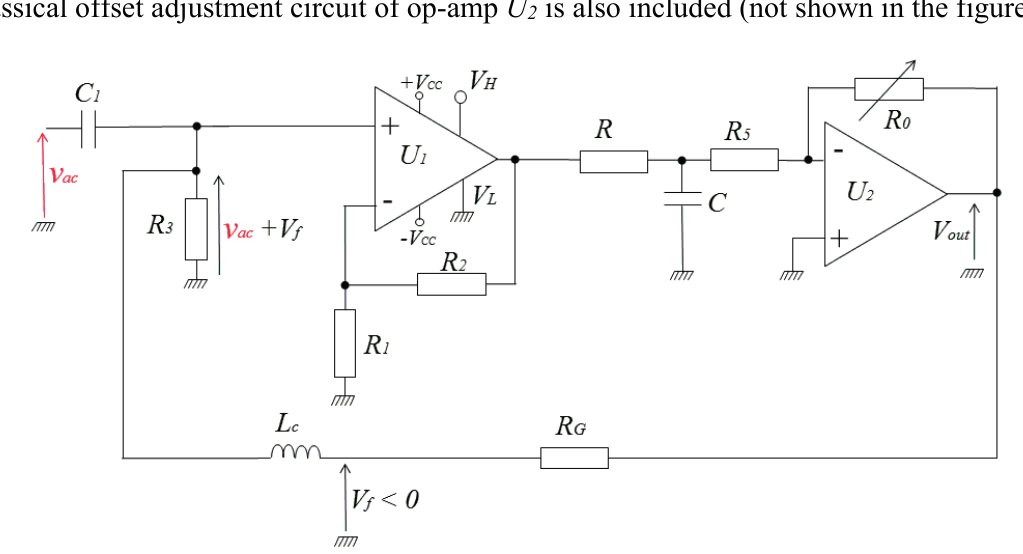
Figure 6. The electronic circuitry of the peak detector and optimized values at 1 MHz. U 1 : OPA699, U 2 : TL081, C 1 = 100 nF, R 3 = 1 k Ω , R 1 = 150 Ω , R 2 = 750 Ω, R = 50 Ω, C = 100 nF. R 5 = 200 Ω , R 0 variable 200 k Ω , R G : gain resistor. L c = 3 × 120 µH (choke inductor). The